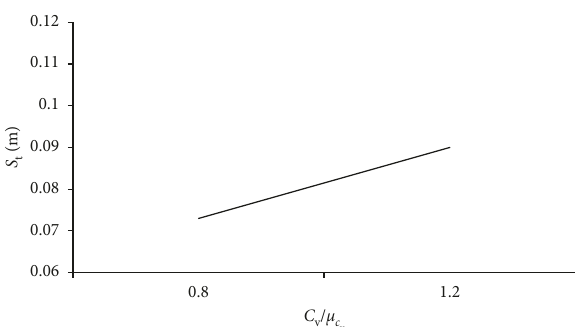
Figure 7: Effect of consolidation coefficient on the final consoli- dation settlement.